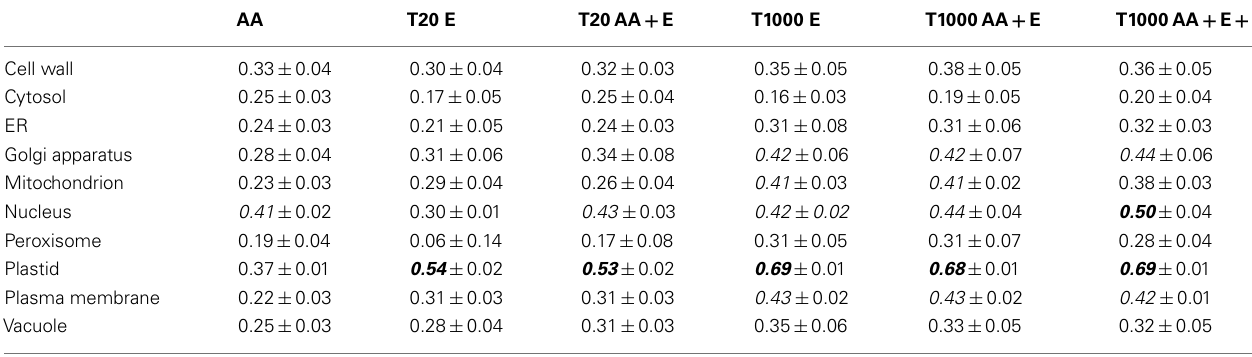
Table 3 | Matthew’s correlation coefficient values obtained using different